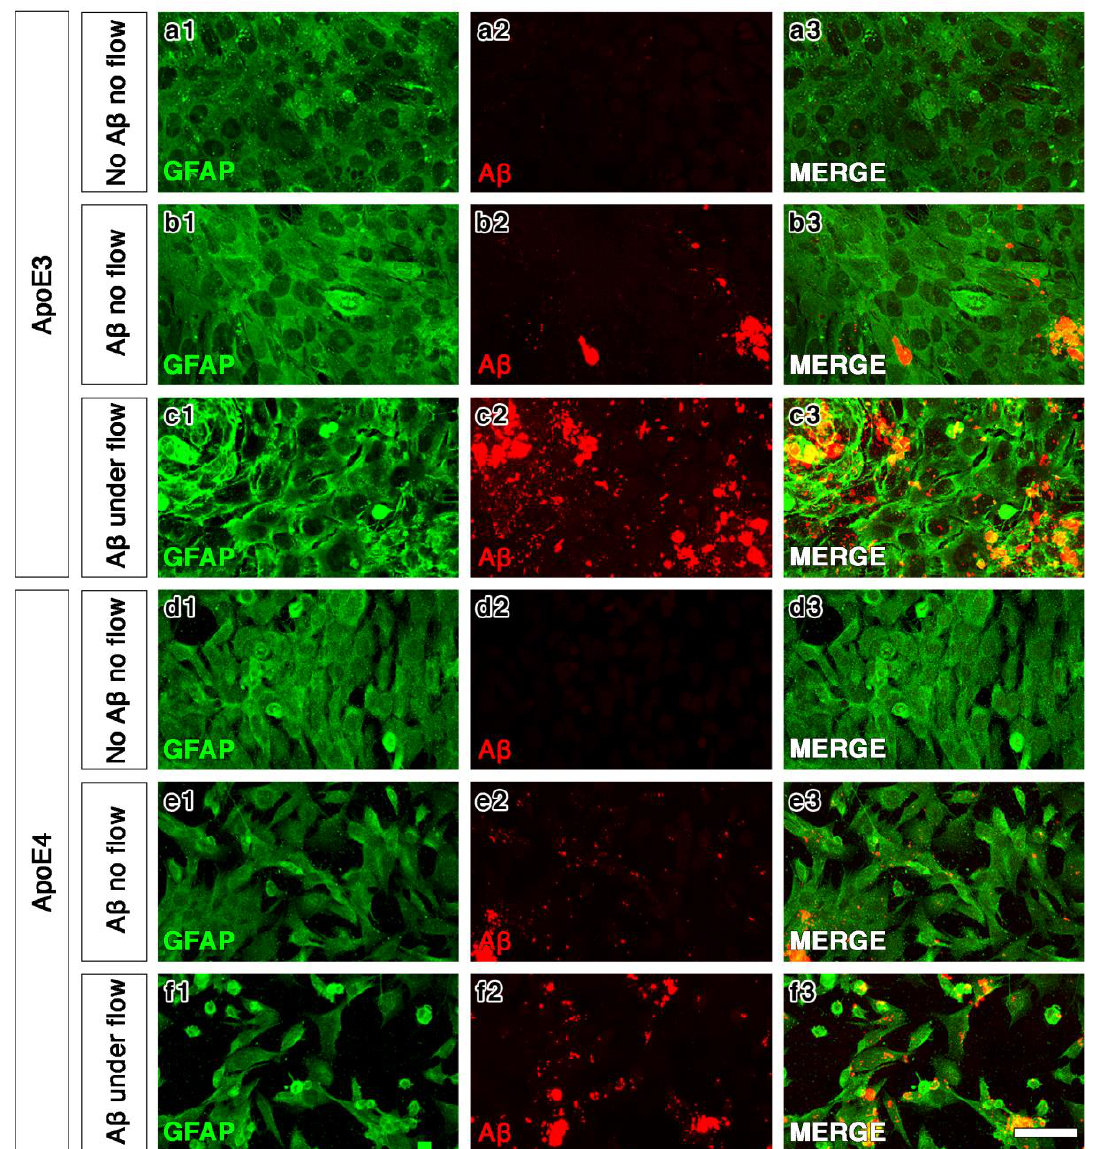
Figure 3. Confocal images of ApoE3/ApoE4 astrocytes after incubation with no Aβ ( a1 – a3 , d1 – d3 ), Aβ for 24 h in static conditions ( b1 – b3 , e1 – e3 ) or Aβ for 24 h with flow ( c1 – c3 , f1 – f3 ) in the Quasi Vivo system. Both genotypes showed a similar distribution and aggregation of Aβ under no flow ( b2 , e2 ) that became more widespread under flow ( c2 , f2 ). Flow conditions did not affect the appearance of ApoE3 astrocytes ( b1 , c1 ), but did affect ApoE4 astrocytes with a more sparse arrangement under flow ( e1 , f1 ). Colour representations are: green: GFAP ( a1 , b1 , c1 , d1 , e1 , f1 ); red: Aβ ( a2 , b2 , c2 , d2 , e2 , f2 ); and, overlay ( a3 , b3 , c3 , d3 , e3 , f3 ). Scale bar: 75 µm.